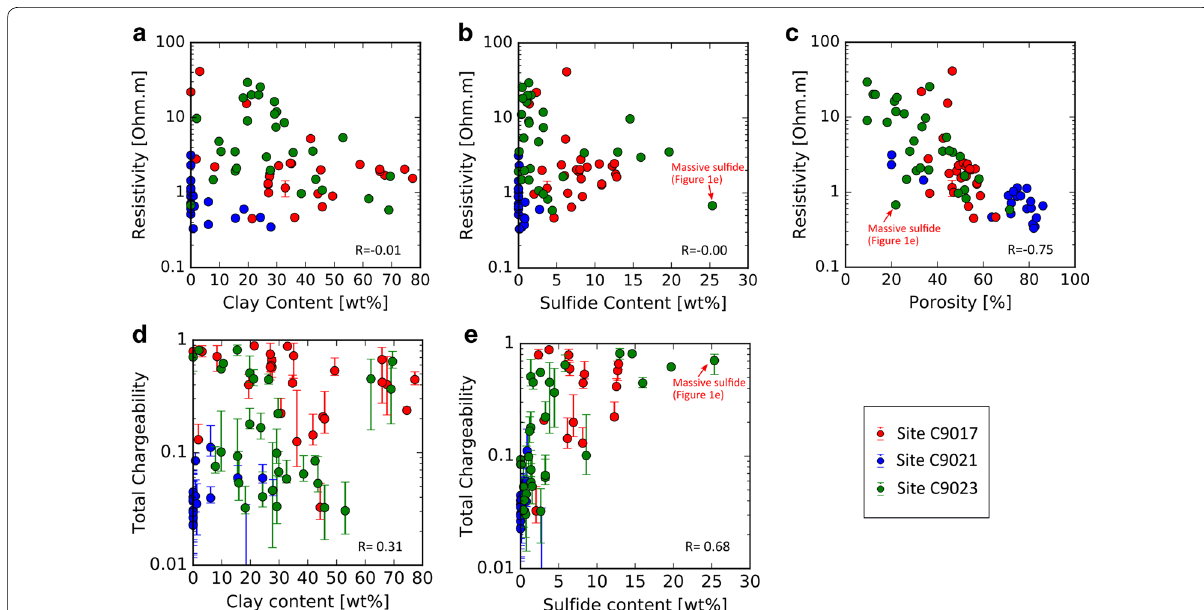
Fig. 5 a – c Comparison between resistivity, clay content, sulfide content, and porosity. d – e Comparison between total chargeability, clay content, and sulfide content. The R value represents the correlation